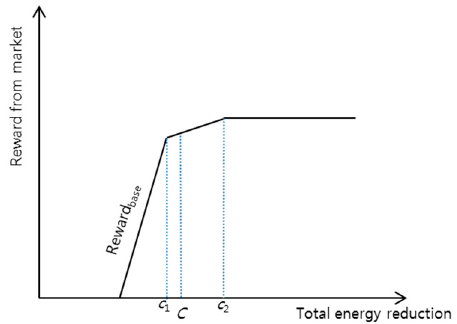
Figure 2. Reward function of a DRSP. A DRSP declares its capacity ( C ). A DRSP must pay a penalty if it does not reach its predetermined threshold ( c 1 , 0.97 × C in Korea). The reward will be given only until energy reduction reaches the predetermined threshold ( c 2 , 1.2 × C in